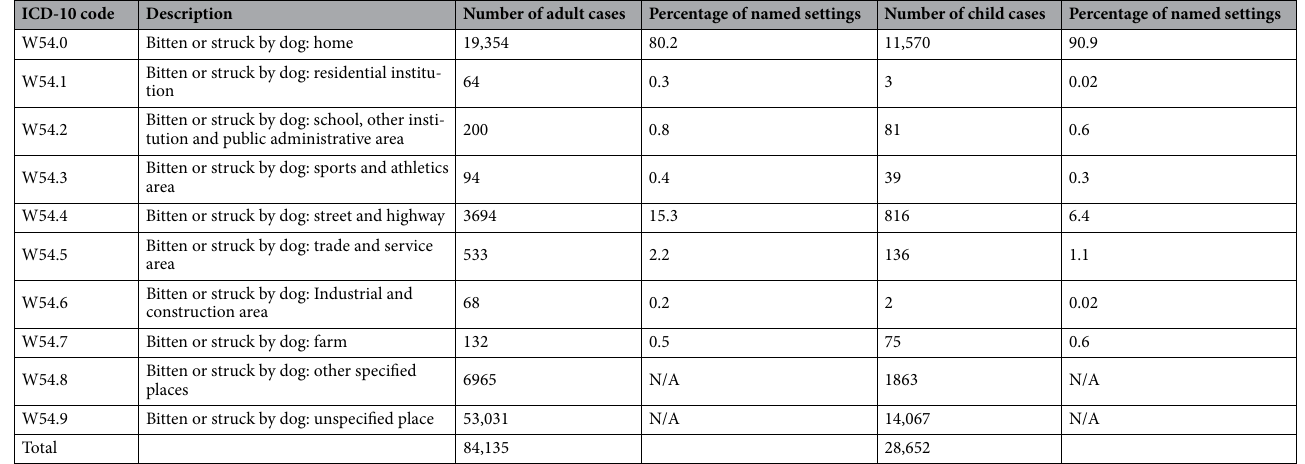
Table 1. ICD-10 ‘dog bite’ codes stratified by child–adult